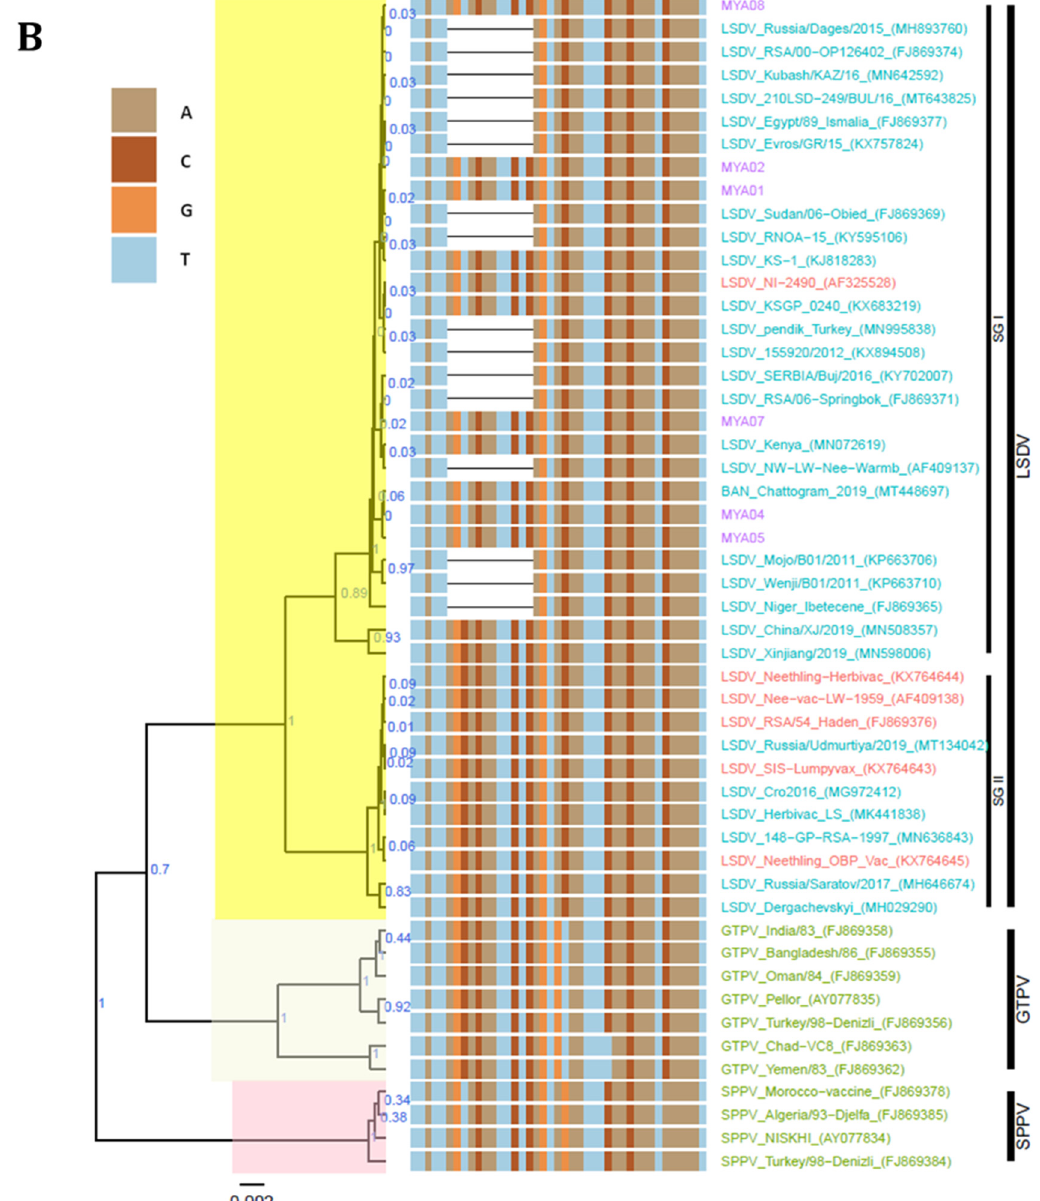
Figure 5. Maximum clade credibility (MCC) tree based on ( A ) the complete RPO30 gene sequences and ( B ) the complete GPCR gene sequences of CaPVs, plotted together with a portion of the GPCR multiple sequence alignment between 80 and 120 nucleotide positions. LSDV isolates from Myanmar are highlighted in violet.